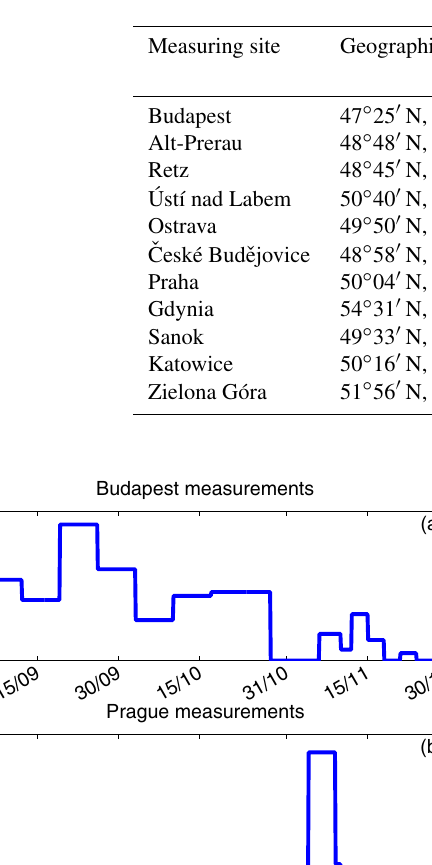
Table 1. List of the sampling sites from which 131 I measurements were used in this study. NRIRR – National Research Institute for Radio- biology and Radiohygiene (regular on-site radiological measurements in NRIRR, http://www.osski.hu), Hungary; AGES – Austrian Agency for Health and Food Safety, Austria; SUJB – State Office for Nuclear Safety (data retrieved from the Monitoring of Radiation situation database, MonRaS, http://www.sujb.cz/monras/aplikace/monras_en.html), Czech Republic; SURO – National Radiation Protection Institute, Czech Republic; CLRP – Central Laboratory for Radiological Protection, Poland.